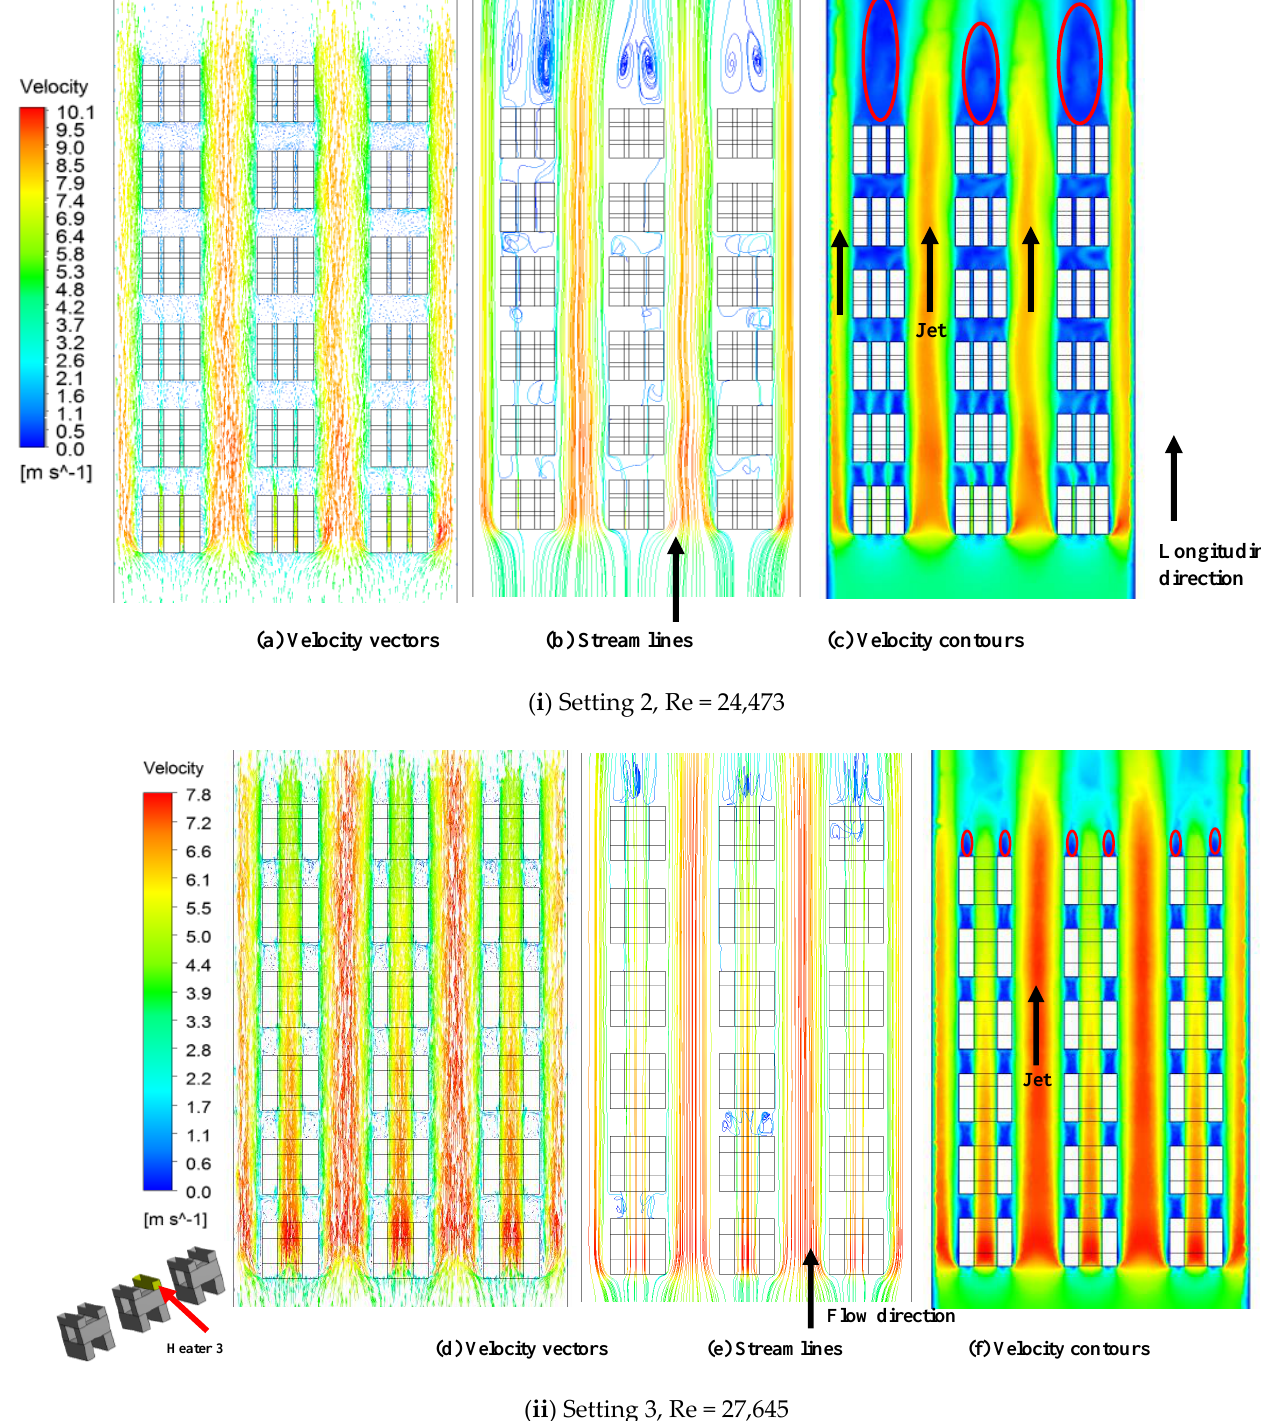
Figure 9. Flow characteristics at the top plane (Top 3) pass through heater 3, ( i ) setting 2, ( ii ) setting 3.